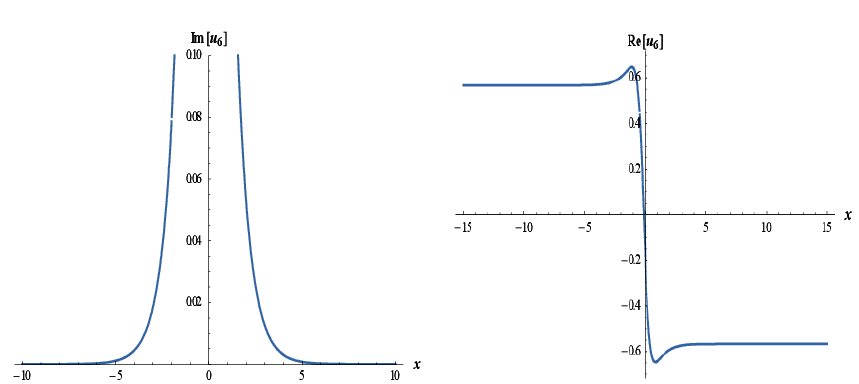
Figure 14. Contour graphs of imaginary and real part of (34).